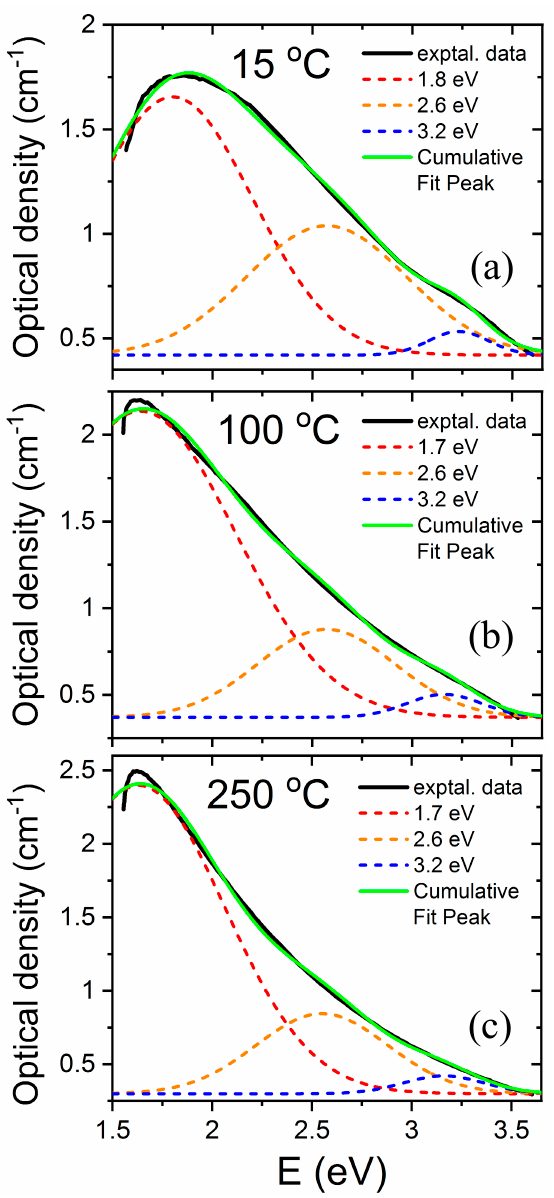
Figure 2. Absorption spectra and Gaussian decomposition obtained for congruent LiNbO 3 irradiated with high-energy electrons at various temperatures ( a ) 15 °C, ( b ) 100 °C, ( c ) 250 °C. This figure has been adapted from Hodgson et al. [32], Copyright (1987), with permission from Elsevier.